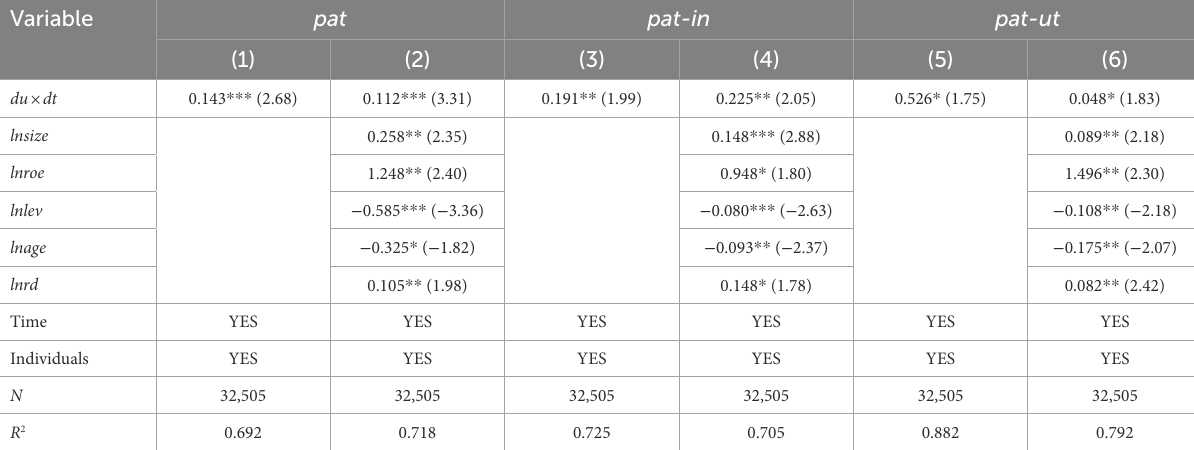
TABLE 1 Regression results of the baseline